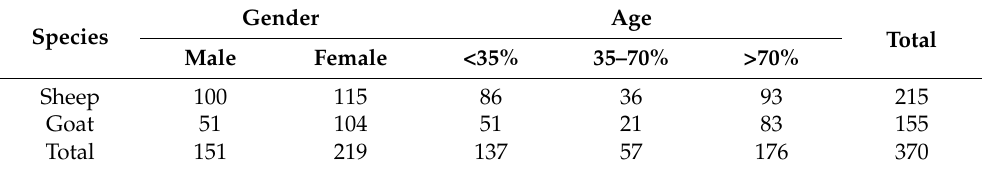
Table 1. Examined number of sample carcasses according to species, gender and age.